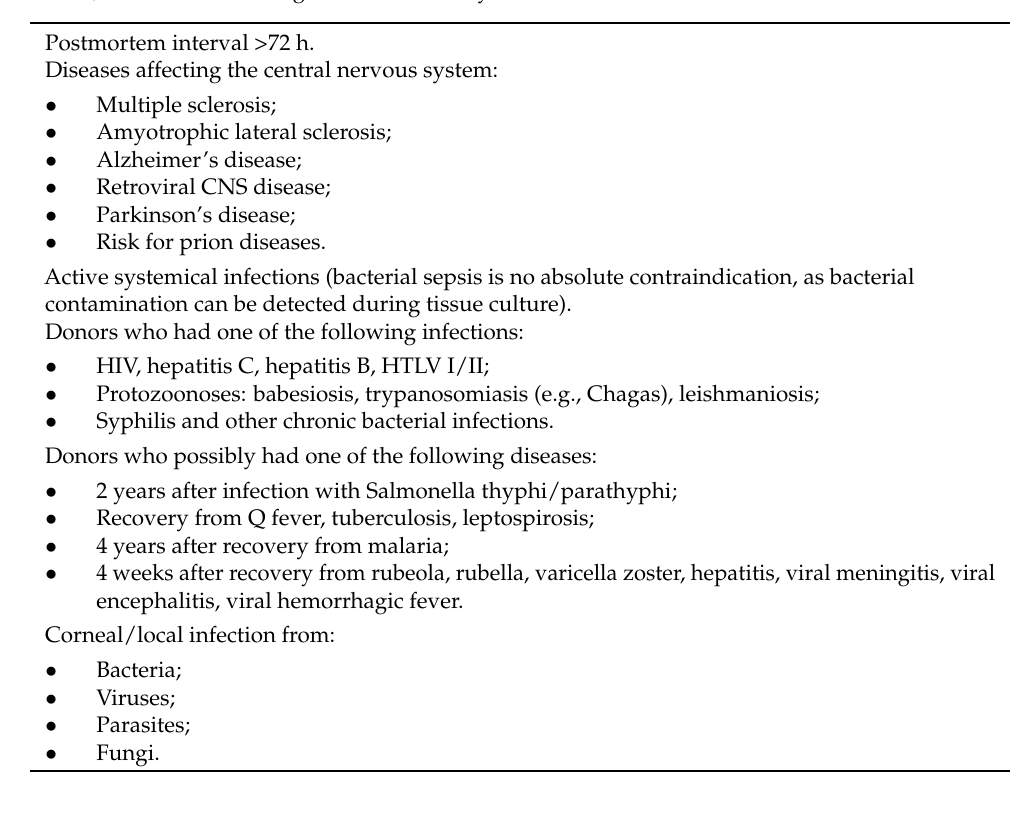
Table 1. Exclusion criteria for corneal donor grafts of the Eye Bank of the University Medical Center Mainz, evaluated according to medical history 1